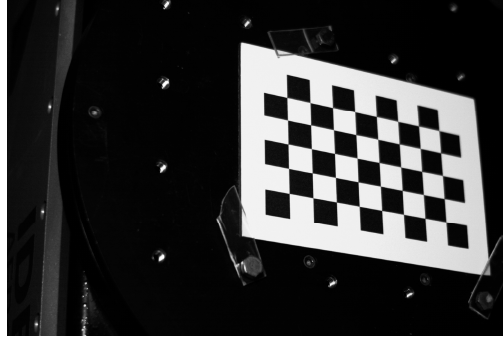
Figure 13. Checkerboard target mounted on top of the Ideal Aerosmith 2102C turntable, for verification of the monocular vision system.